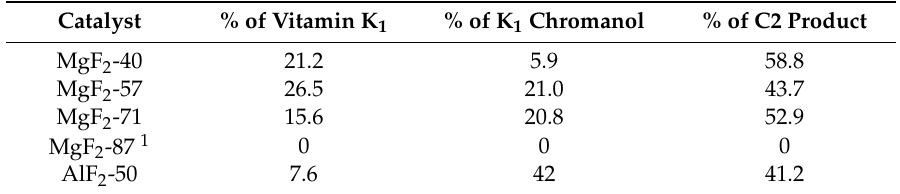
Table 3. The catalytic results in the synthesis of vitamin K 1 , K 1 -chromanol, and C2-alkylated product from menadiol